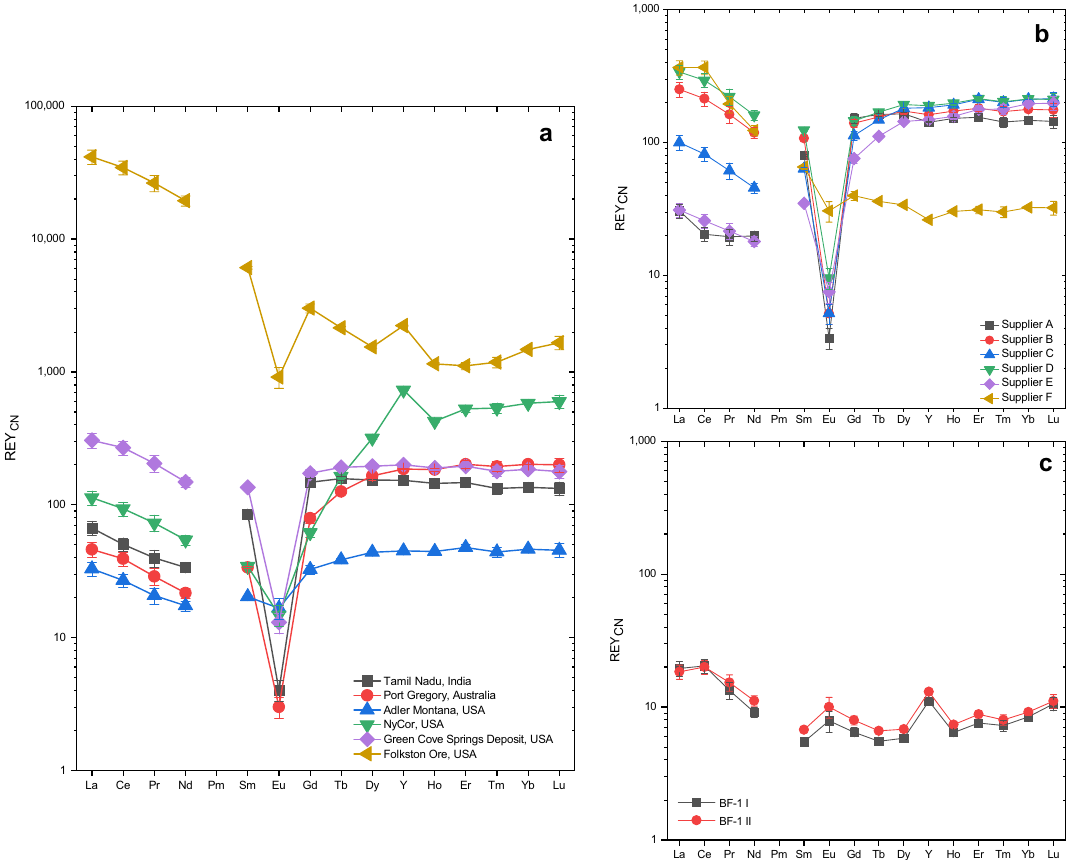
Figure 1. Chondrite-normalized REY patterns of garnet sand from different deposits ( a ), commercially available industrial garnet sands ( b ) and of low-temperature hydrothermal garnet from the Paleoproterozoic Beaumont Formation, South Africa ( c ). The error bars are based on 2 times the relative standard deviation (RSD) of the repeated measurement of sample Supplier C b on two different ICP-MS. Note that for some REY the error bar is smaller than the symbol